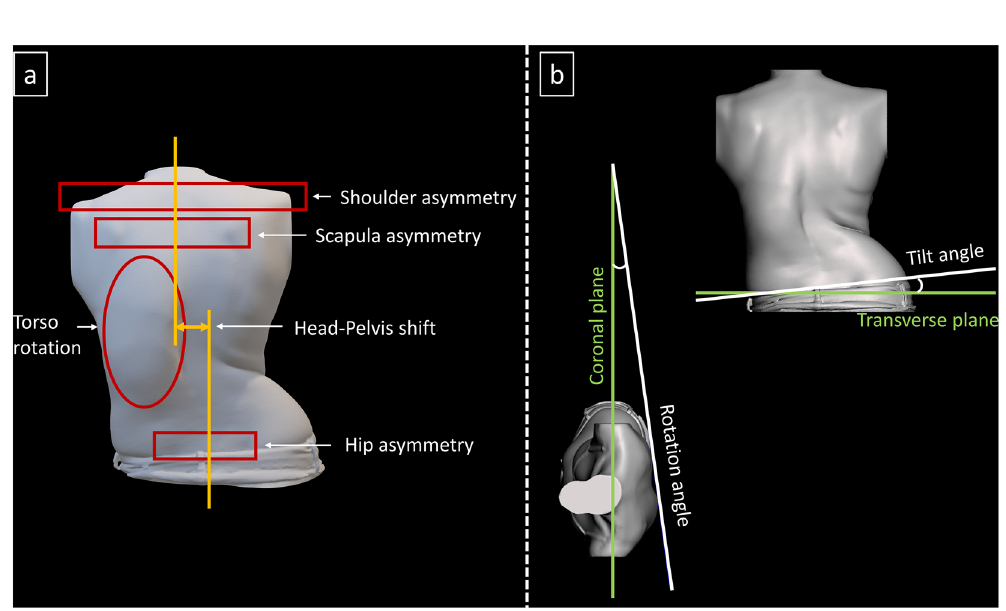
Fig 2. Metrics definition. ( a ) 5 key AIS metrics measurement regions, ( b ) Rotation and tilt